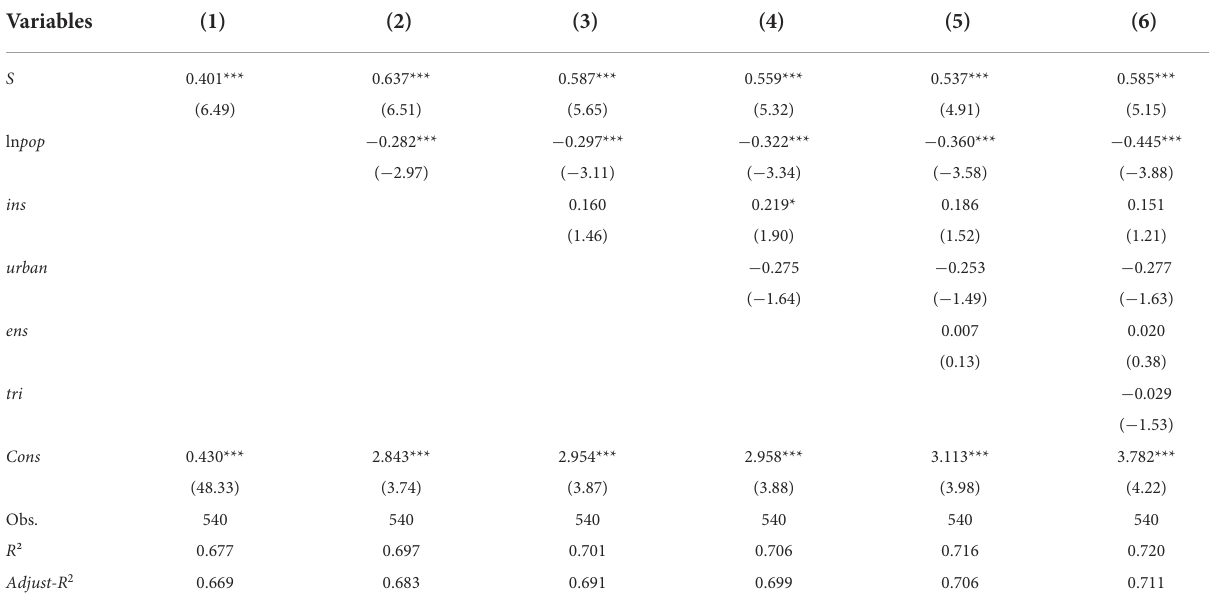
TABLE 5 Basic estimation results without spatial effects.